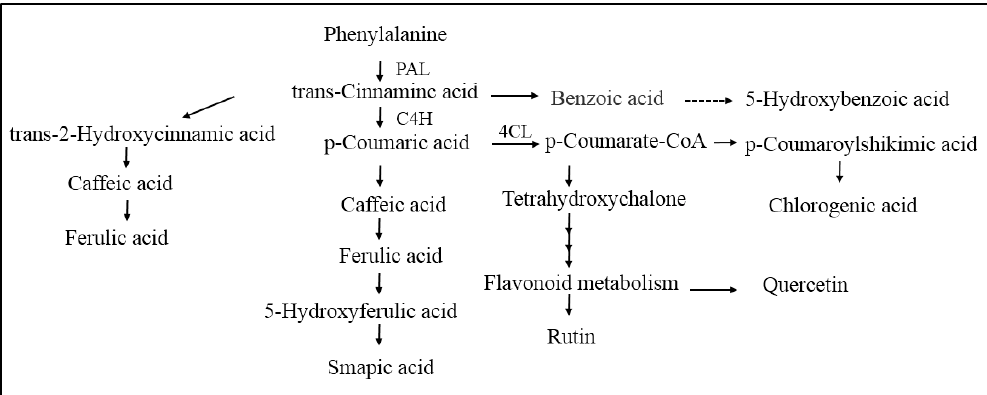
Figure 9. Biosynthesis pathway of phenolic compounds in plants. Table 2. Pearson correlation coefficients of nine kinds of individual phenols, total phenol (TP) content, PAL, C4H, 4CL, PPO, POD enzyme activities. CiA, CaA, SiA, ChA, FeA, and HyA represent cinnamic acid, caffeic acid, sinapic acid, chlorogenic acid, ferulic acid, and hydroxybenzoic acid, respectively.